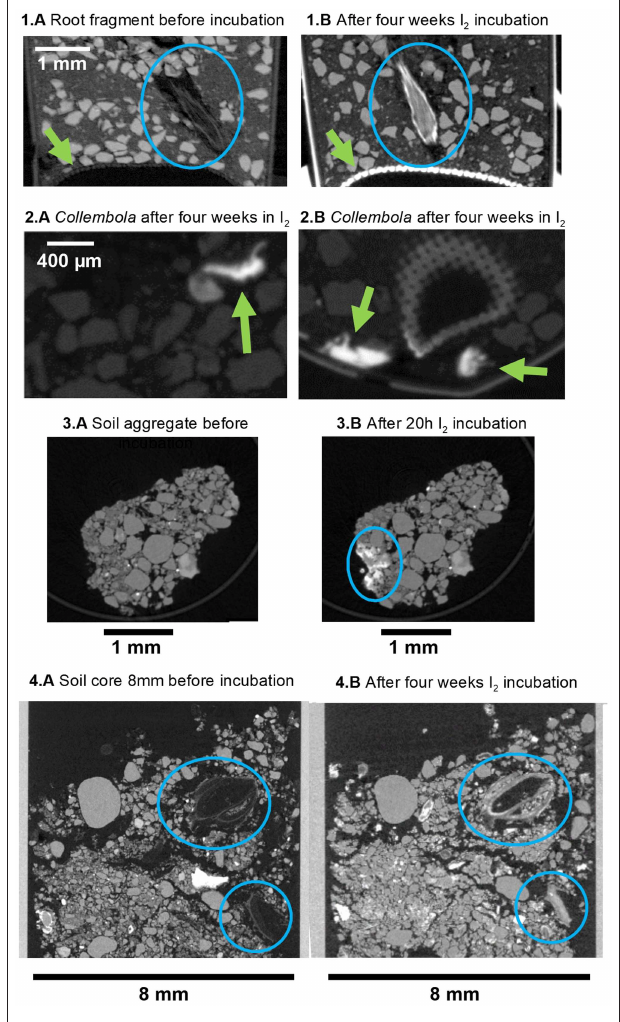
FIGURE 5 | Reconstruction images of the conventional X-ray tomographies ( µ CT, 50 kV, 7 µ m voxel resolution) of soil samples: (1A) clay/sand mix control with detail of the root fragment inside before incubation and (1B) after additional 4 weeks I 2 incubation; (2A,B) clay/sand mix control with detail of the Collembola inside; (3A) soil aggregate before incubation and (3B) after 20h I 2 incubation; (4A) details of organic material in a soil core of 8mm before incubation and (4B) after additional 4 weeks I 2 incubation. Details that are mentioned in the text are highlighted with blue circles or green